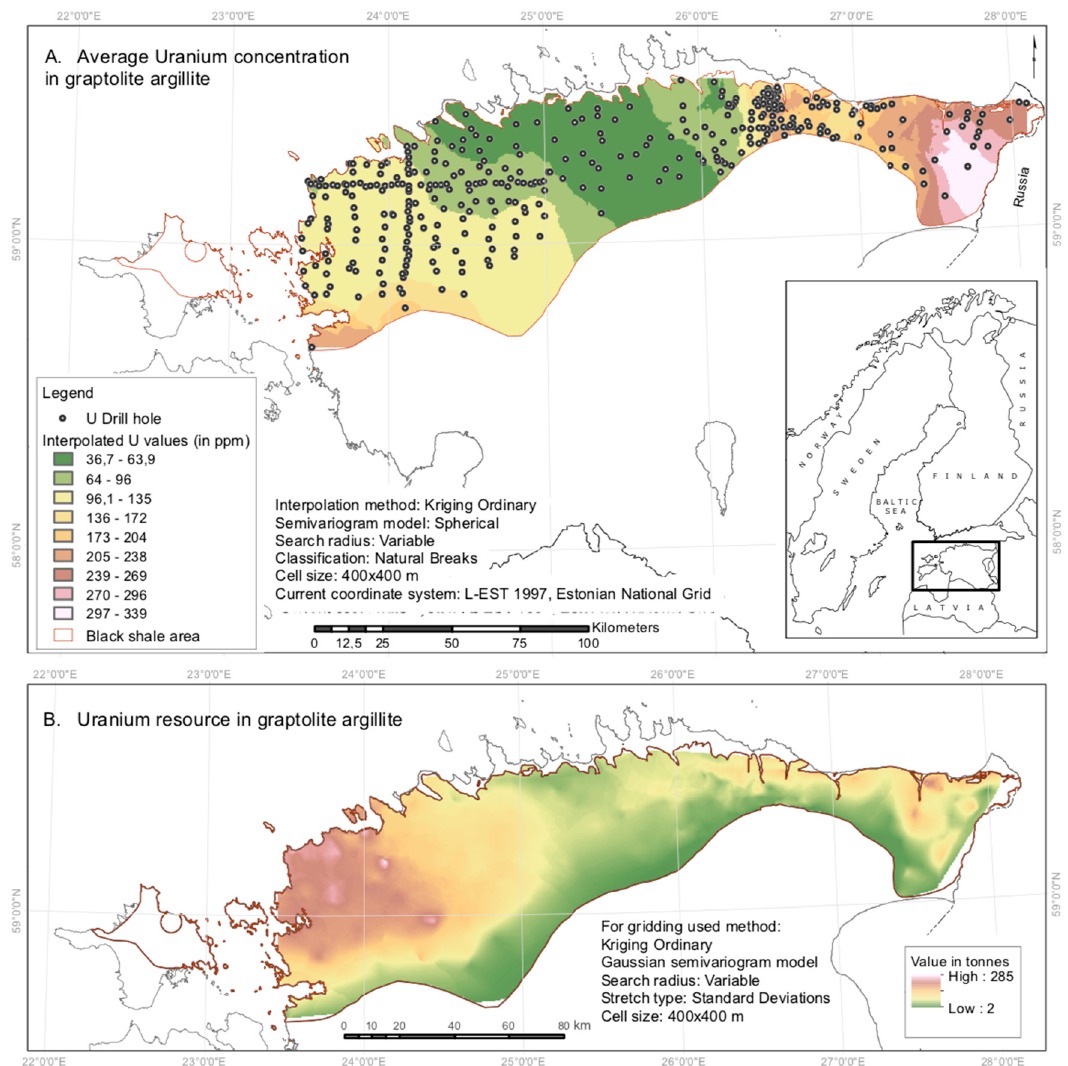
Figure 3. ( A ) Location map of the drill holes penetrating the graptolite argillite layers and the extent of the graptolite argillite. U tonnage model in the 400 to 400 m cell at the modeled thickness of the graptolite argillite. ( B ) Modeled uranium content in the Estonian GA based on calculated average drill core contents (data: Geological Survey of Estonia; www.maaamet.ee [3]).